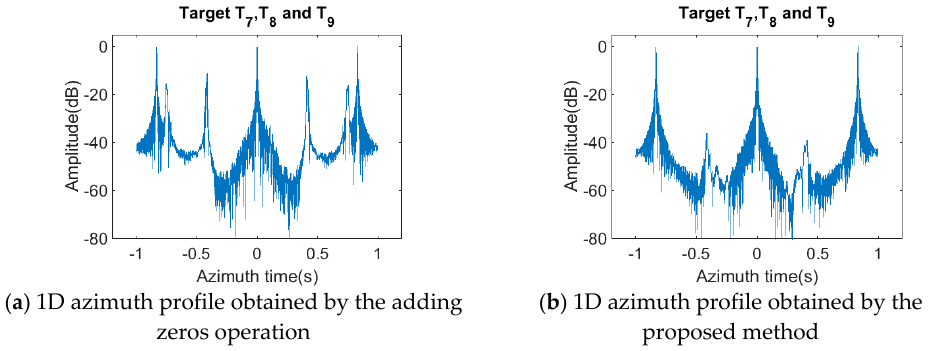
Figure 16. 1D Azimuth profiles of T 7 , T 8 , and T 9 : ( a ) 1D azimuth profile obtained by the adding zeros operation; and ( b ) 1D azimuth profile obtained by the proposed method.